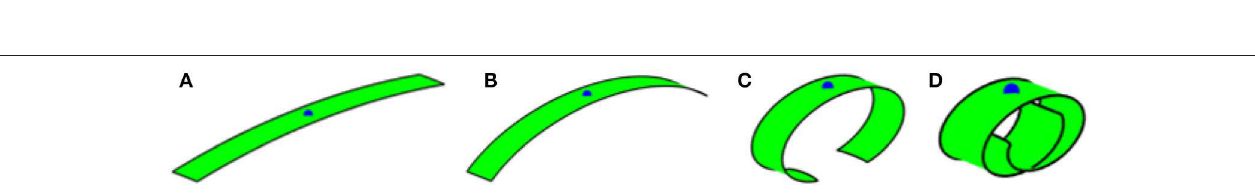
FIGURE 4 | Folding of 50 × 25rectangular plate. (A) Electric field 25 MV/m; (B) electric field 43 MV/m; (C) electric field 68 MV/m; and (D) electric field 86 MV/m.